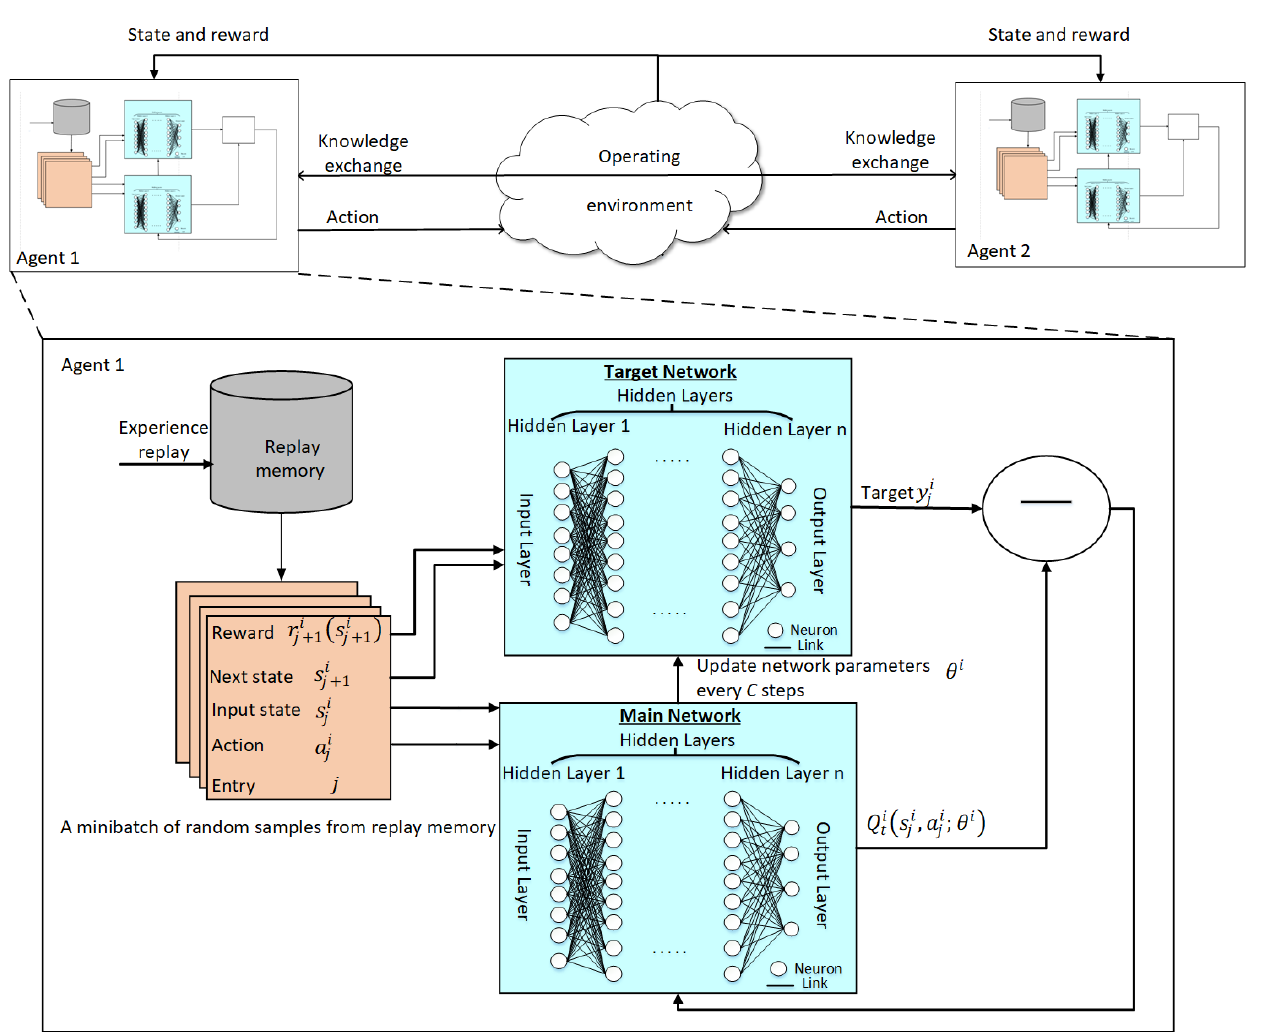
Figure 1. An example of a MADQN architecture. Two agents exchange information (e.g., Q-values) used to update their respective Q-values. Each agent observes and stores its state and reward from the operating environment in replay memory for training, and selects its own action. Agent 1 is enlarged to show: (a) the replay memory; (b) the main network that produces Q-values for all possible actions given a particular state; and (c) the target network that produces a stable target used to compute the loss of the selected